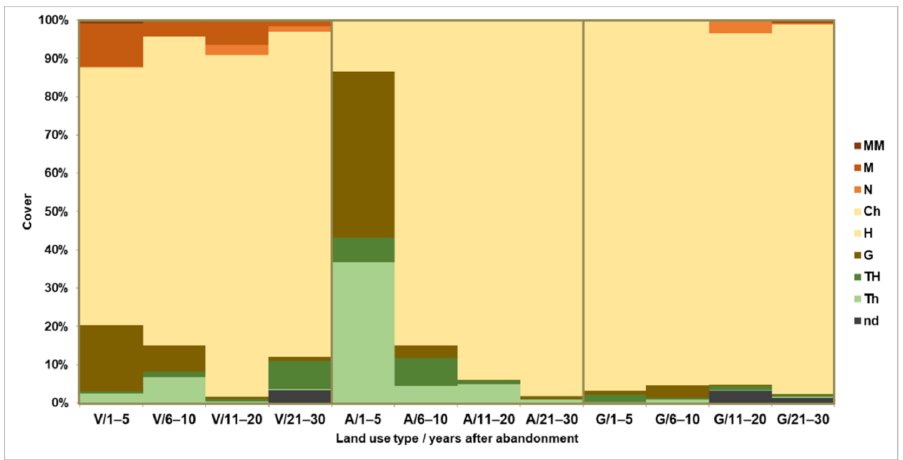
Figure 5. Distribution of Raunkiaer life forms in age groups of abandoned lands (MM— mesophanerophytes, M—microphanerophytes, N—nanophanerophytes, Ch—chamaephytes, H— hemicryptophytes, G—geophytes (cryptophytes), TH—hemitherophytes, Th—therophytes, nd— no